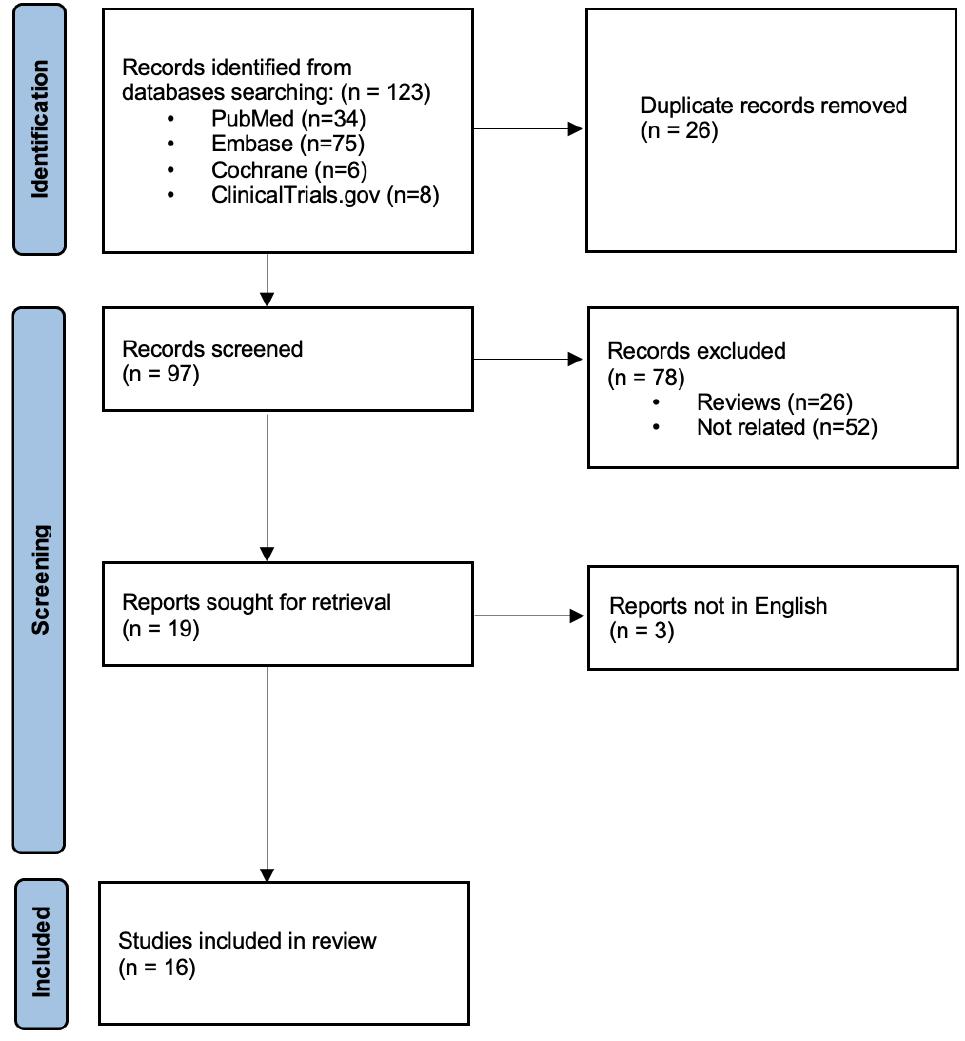
Figure 1. Flow diagram of study selection process.